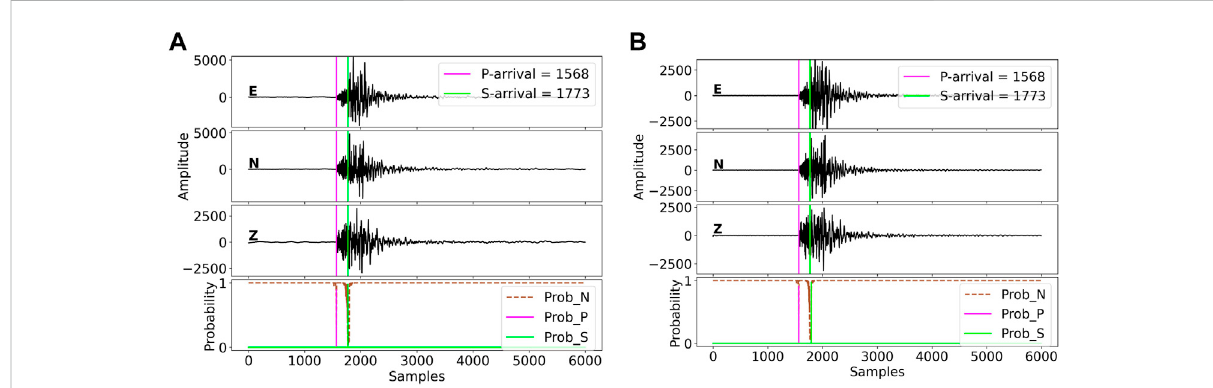
FIGURE 7 Output visualization of a low SNR data including (A) raw data and (B) data processed with a band-pass fi lter. For this trace example, the mean SNRoverthreecomponentsis35.39dB,withmagnitude=1.5anddepth=9.8 km.Thetopthreesub- fi guresrepresentthethree-componentseismic recordings,namely, ‘ E ’ (east – west), “ N ” (north – south),and “ Z ” (verticaldirection), respectively. Thebottomsub- fi gureplots thepredictedprobability corresponding to thethree classes: “ noise ” , fi rst P-wave, and fi rst S-wave.The coloredvertical lines in thetop three sub- fi gures denotethe fi rst arrival times of P- and S-phases corresponding to the earthquake catalog of the used INSTANCE